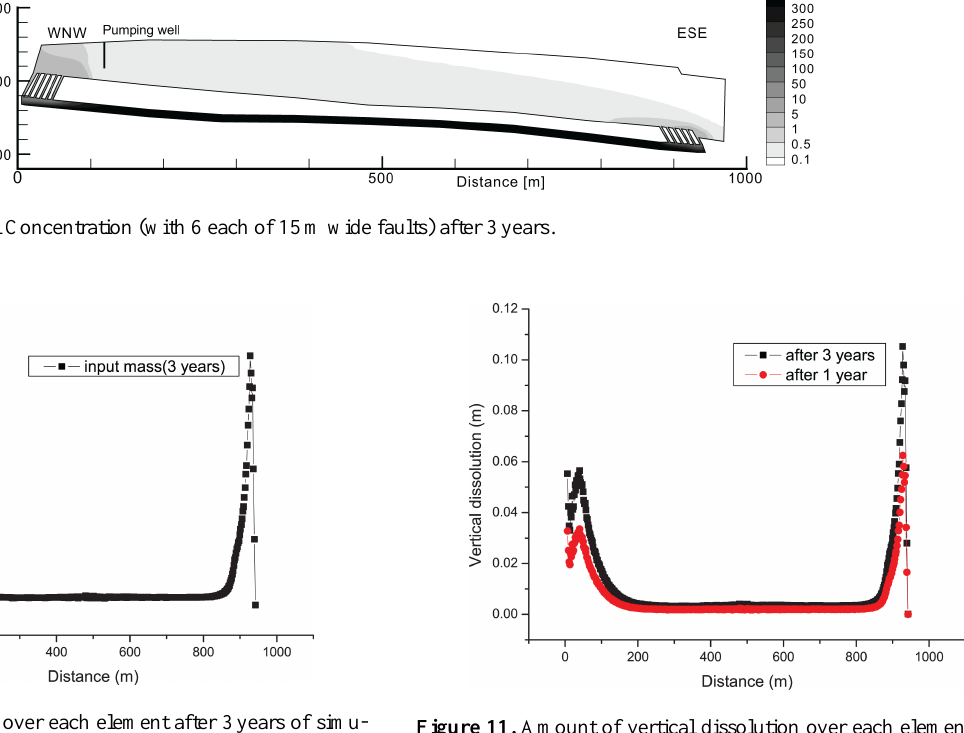
Figure 11. Amount of vertical dissolution over each element after 6months and 3years of simulation with 6 thin